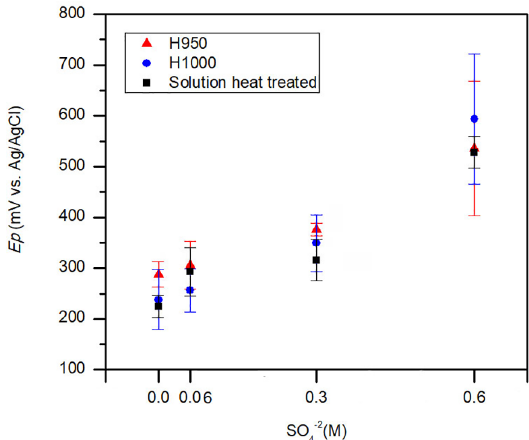
Figure 10. Average pitting potential (Epit) of UNS S46500 in 6M NaCl with sulfate additions.